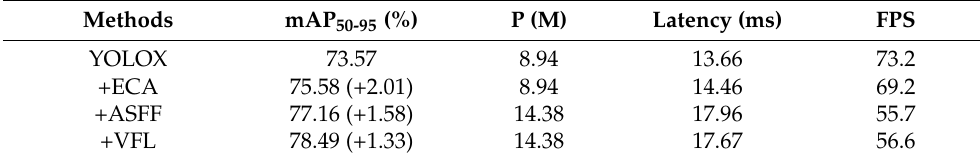
Table 5. The test results of adding each module to YOLOX in turn on DOTA-v1.5.